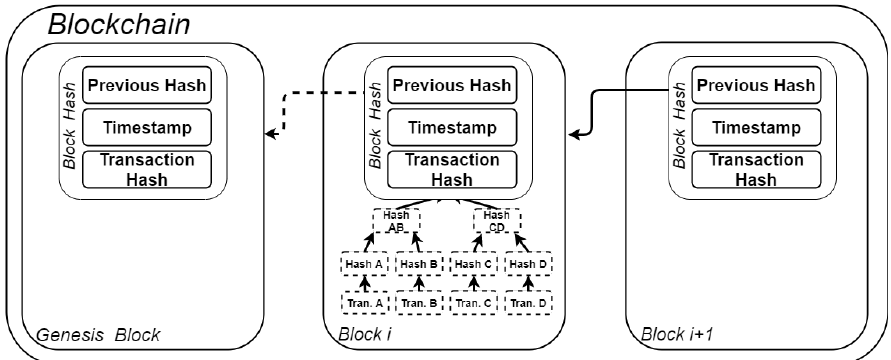
Figure 3. Basic blockchain structure with Merkle tree of transactions for block i The miners (the nodes) of the blockchain can have different roles